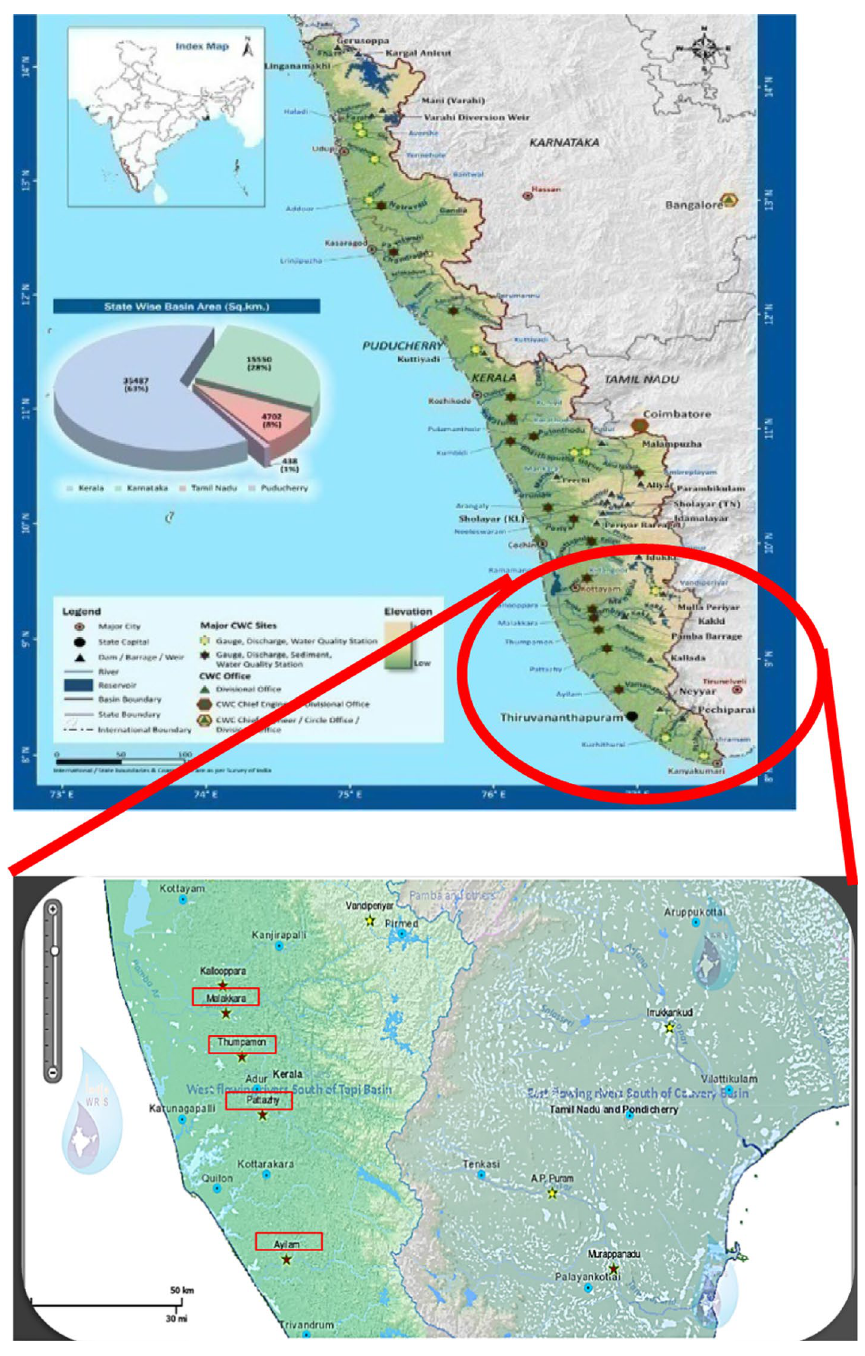
Fig. 3 Map of the four hydro- logic observation stations. Source : www.india -wris.nrsc.